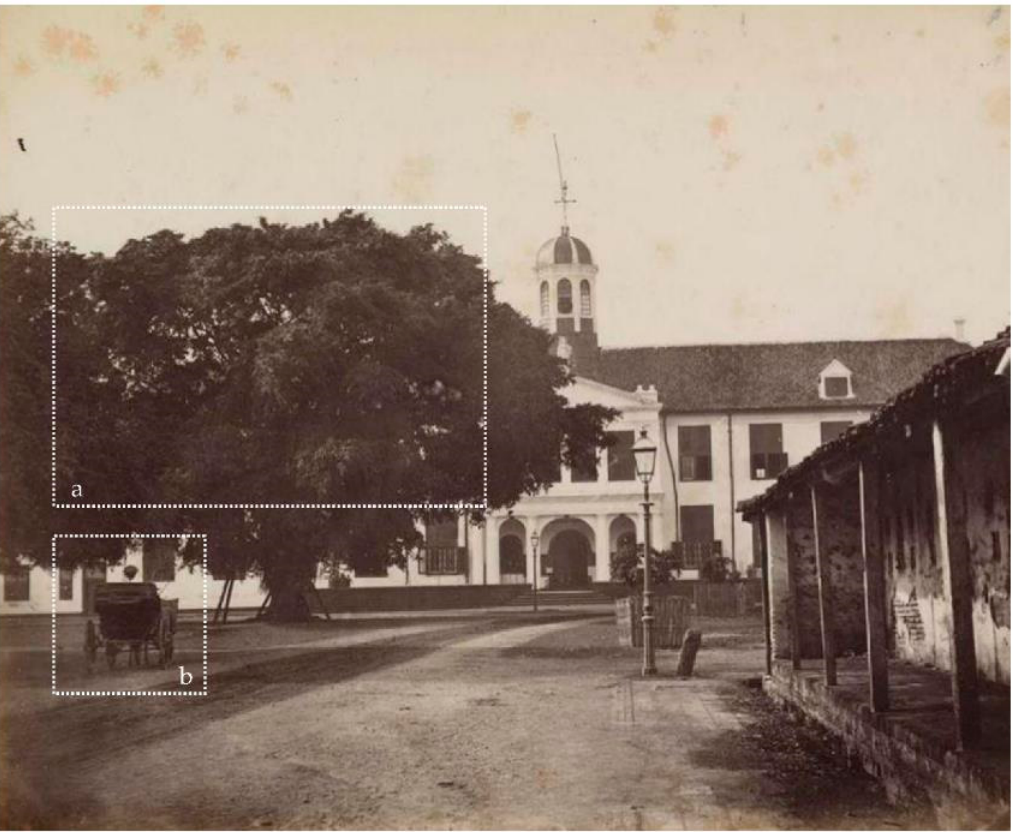
Figure 8. Stadhuis de Batavia from the North in 1880. Identified sound source: ( a ) trees as a source of natural sounds. ( b ) Horse-drawn carriage. Source: Leiden University Digital Collections.